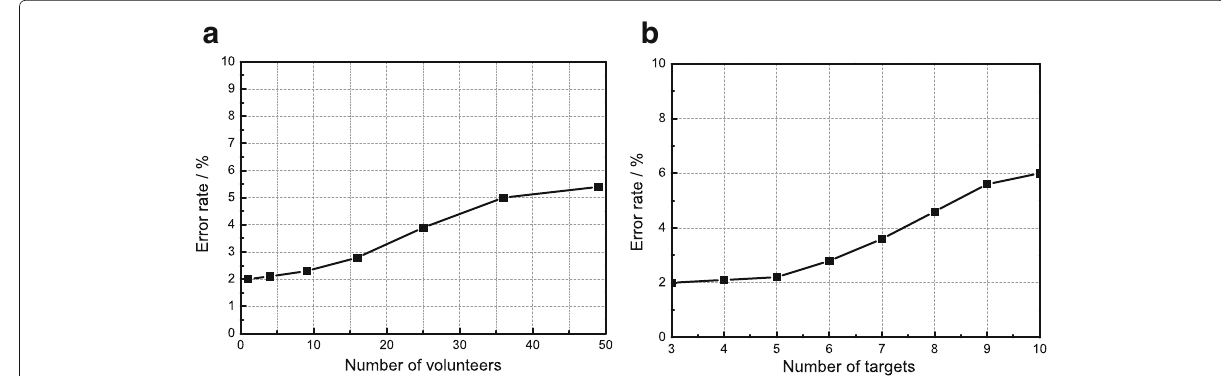
Fig. 11 a Clustering error rate under a different number of target goods. b Clustering error rate under different number of